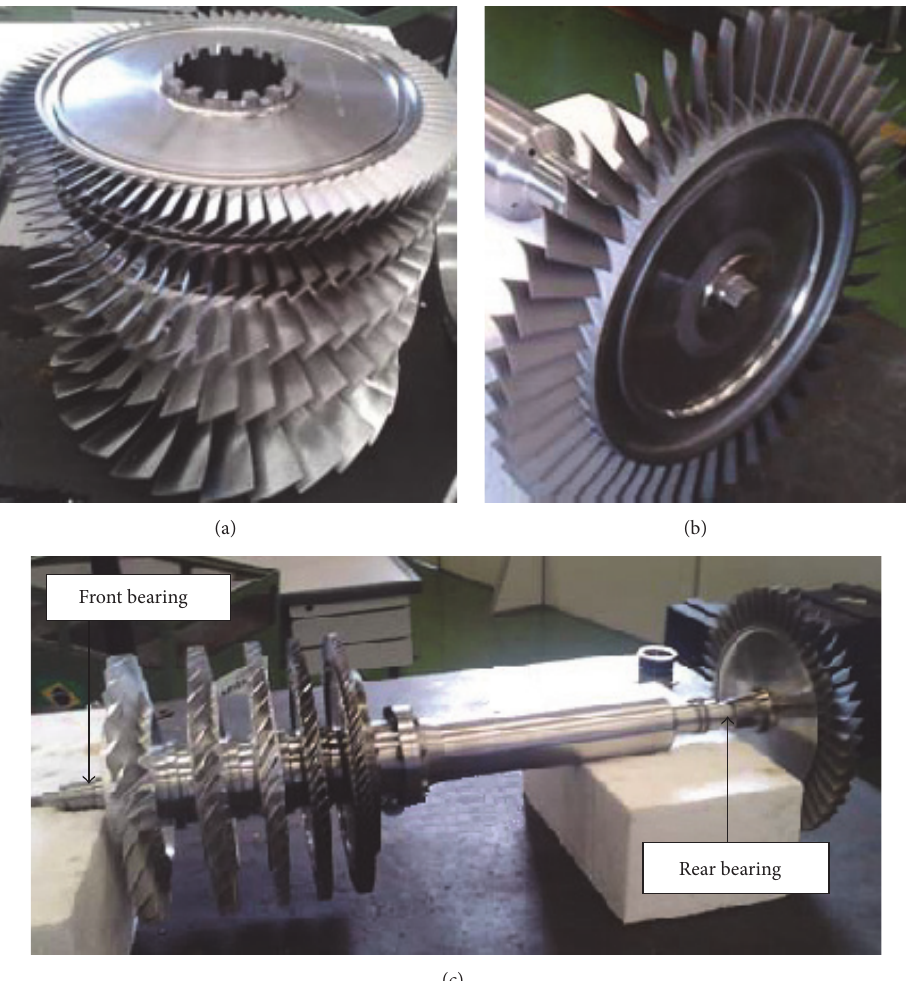
Figure 3: Manufactured rotor-bearing system of the developed gas turbine: (a) compressor discs; (b) free turbine disc; and (c) locations of the